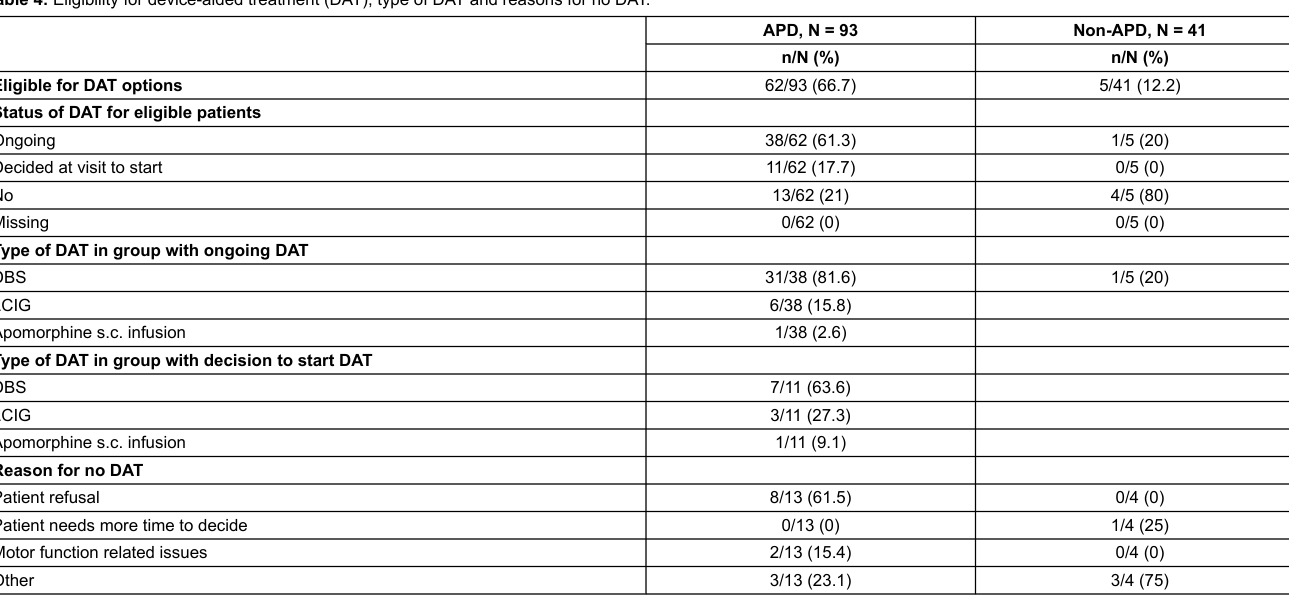
Table 4: Eligibility for device-aided treatment (DAT), type of DAT and reasons for no